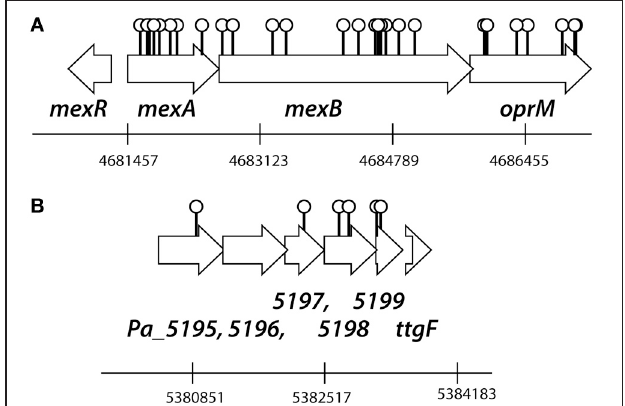
FIGURE 1 | Outline of the transposon insertion positions in the P. azelaica HBP1 genome resulting in abolished growth on 2-HBP. (A) Insertions in the mexAB-oprM gene cluster. (B) Insertions in the putative ABC-type organic solvent resistance efflux system. Positioning and numbering of predicted P. azelaica genes according to a draft genome assembly (van der Meer, unpublished). See further Table S1 and Data File S1 for the DNA and amino acid sequences of the two regions of P. azelaica